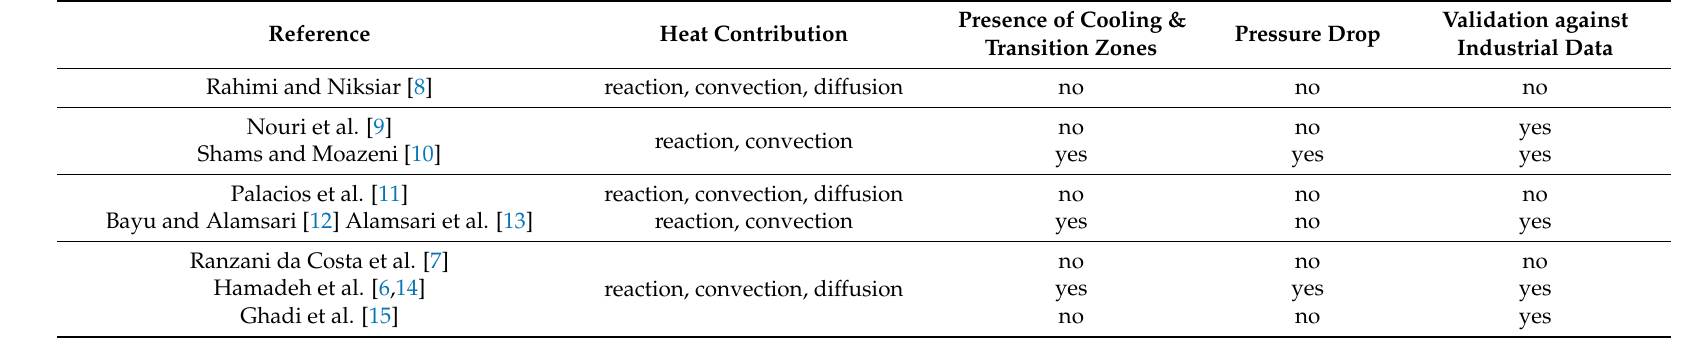
Table 2. Characteristics of DR shaft furnace mathematical models